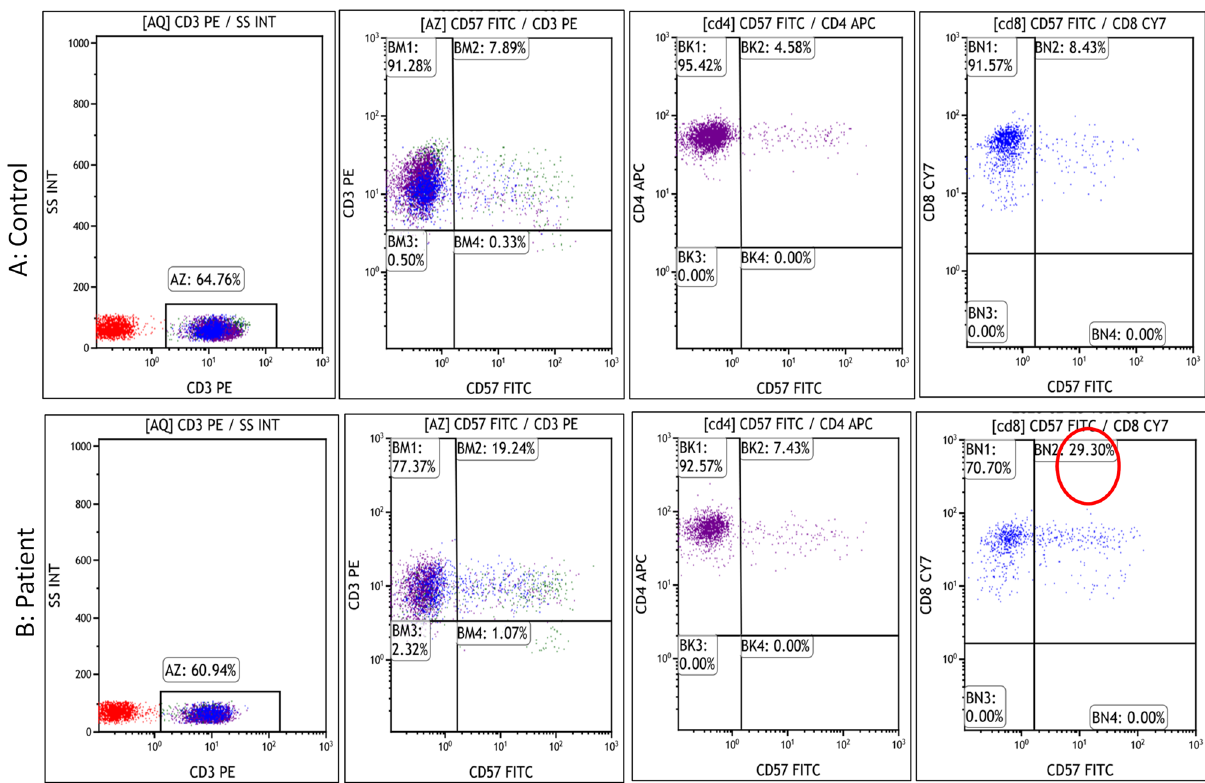
Figure 2. Representative image showing flow cytometric analysis of immunosenescent T lymphocytes in control ( A ) and patient ( B ). Elevated expression of CD57 marker revealed immunosenescence in the CD4+ (7.43% in comparison to the control 4.58%) and CD8+ T cells (29.30% in comparison to the control 8.43%). CD3+ T cells (constituting both CD4+ T helper and CD8+ T cytotoxic cells) were gated on CD3 vs SSc. Further, immunosenescence was estimated on the CD4+ and CD8+